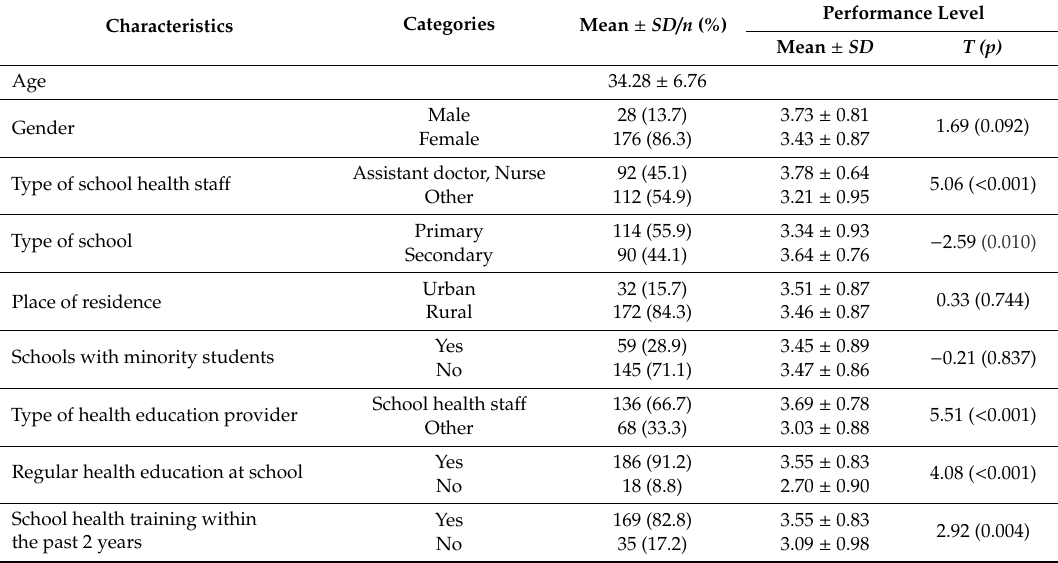
Table 1. Participants’ Characteristics and Di ff erences in School Health Sta ff Members’ Performance ( N =